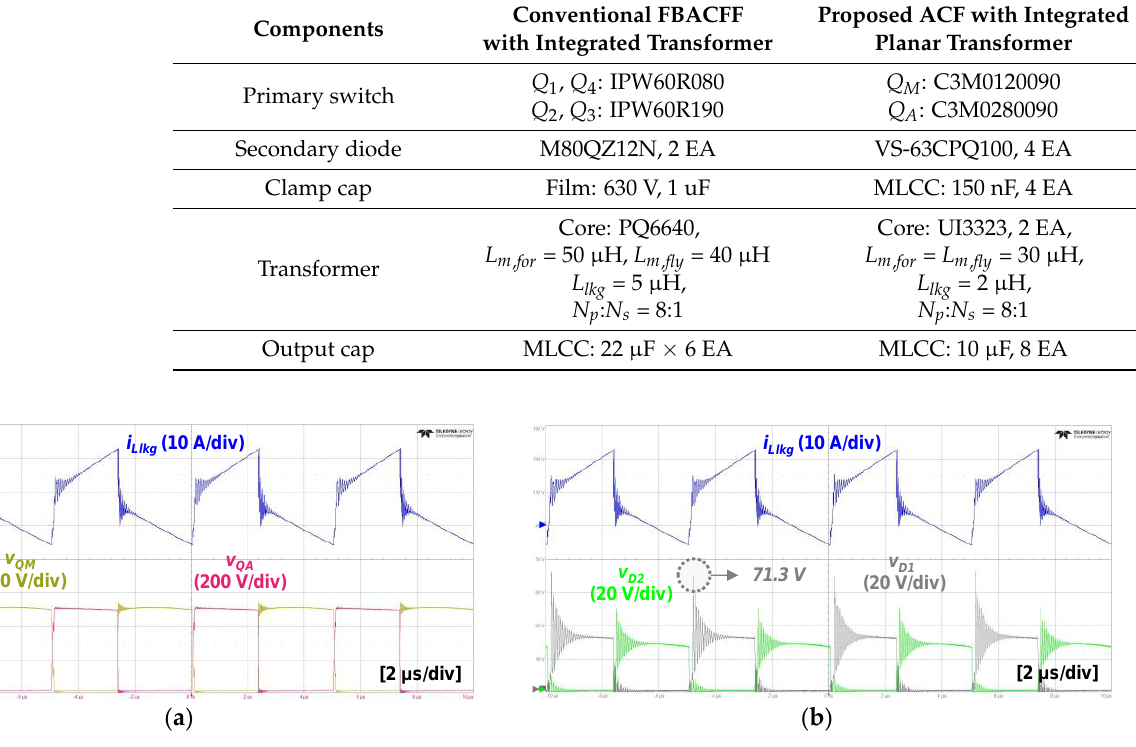
Figure 14. Key experimental waveforms at 270 V input and 100% load conditions: ( a ) Primary side key experimental waveforms. ( b ) Secondary side key experimental waveforms.